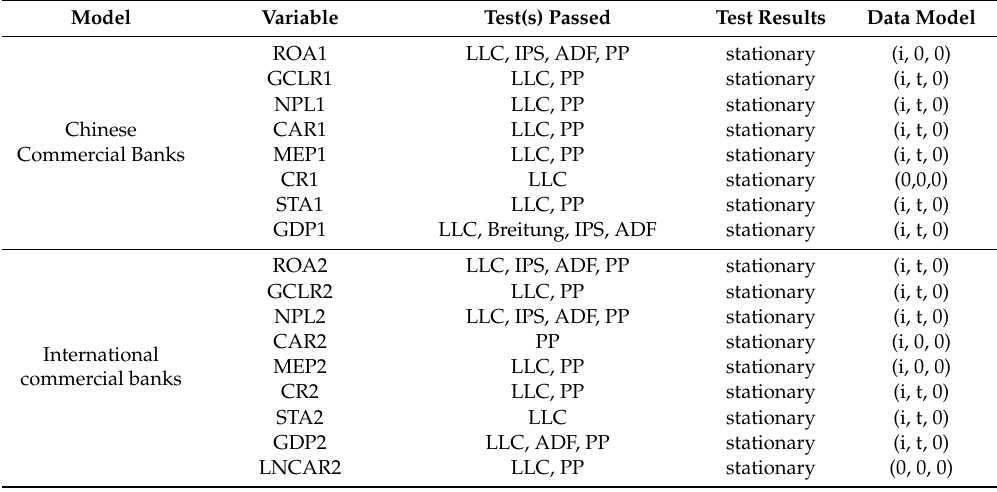
Table 2. Stationarity test